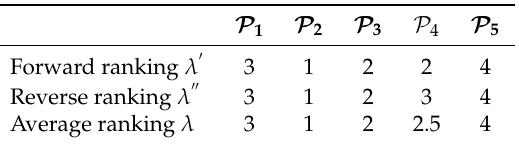
Table 8. Ranking results.